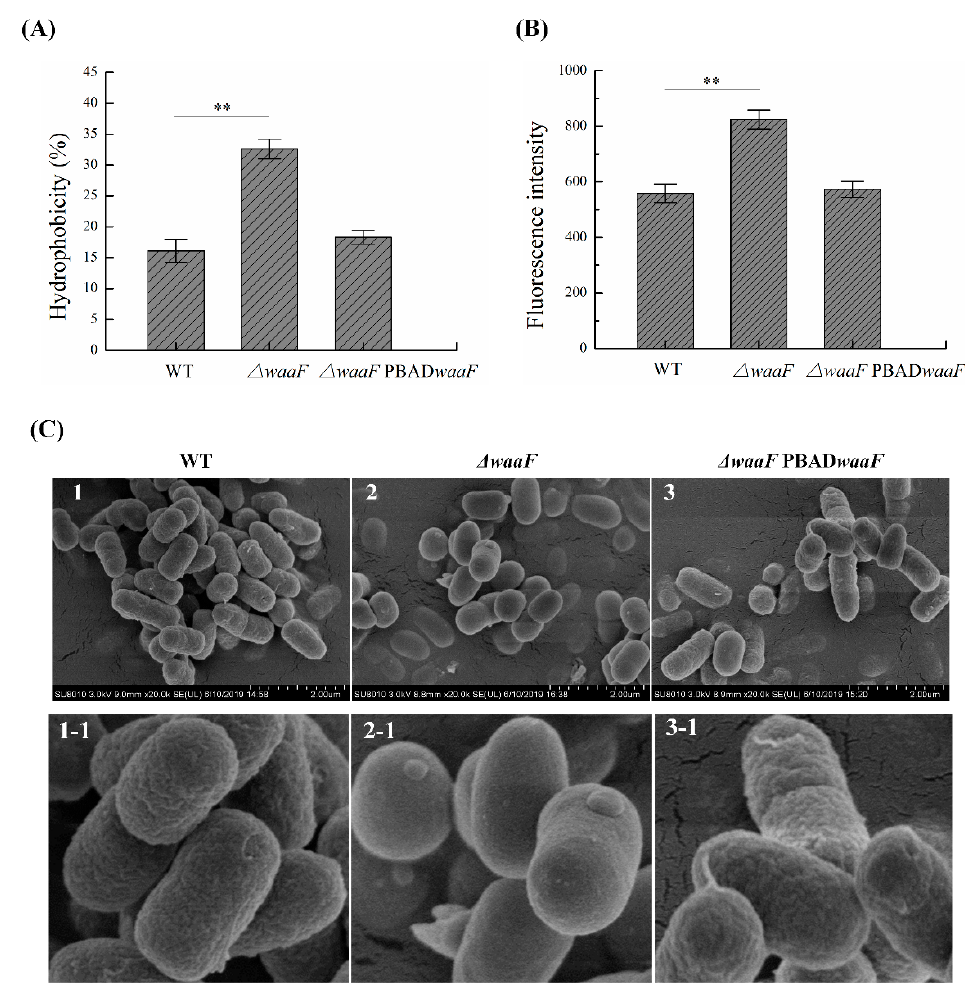
Figure 2. Changes in membrane properties in the wild type, Δ waaF , and Δ waaF -PBAD waaF strains of Y. enterocolitica . ( A ) Changes in cell surface hydrophobicity; ( B ) Changes in outer membrane permeability; ( C ) Scanning electron microscope images of Y. enterocolitica strains. Among them, sub-figures ( 1-1 , 2-1 , 3-1 ) are partial magnified (100 times) views of sub-figures ( 1 – 3 ), respectively. Data